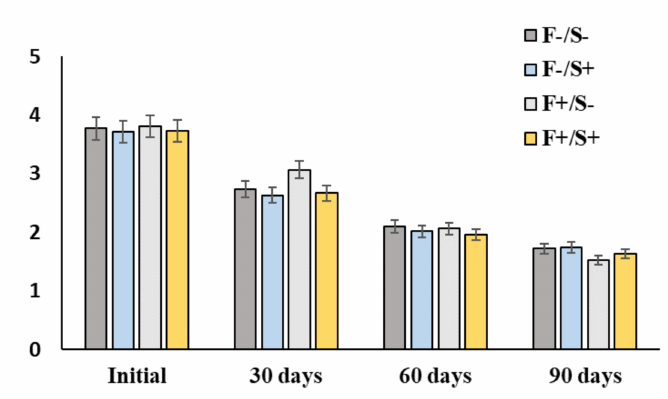
Figure 2. Dynamics of total petroleum hydrocarbons (TPH) concentration changes in soil samples during ex situ remediation. The ordinate axis is the TPH concentration, g / 100 g of soil sample. The zero point represents the data of TPH concentration after introduction petroleum to soil